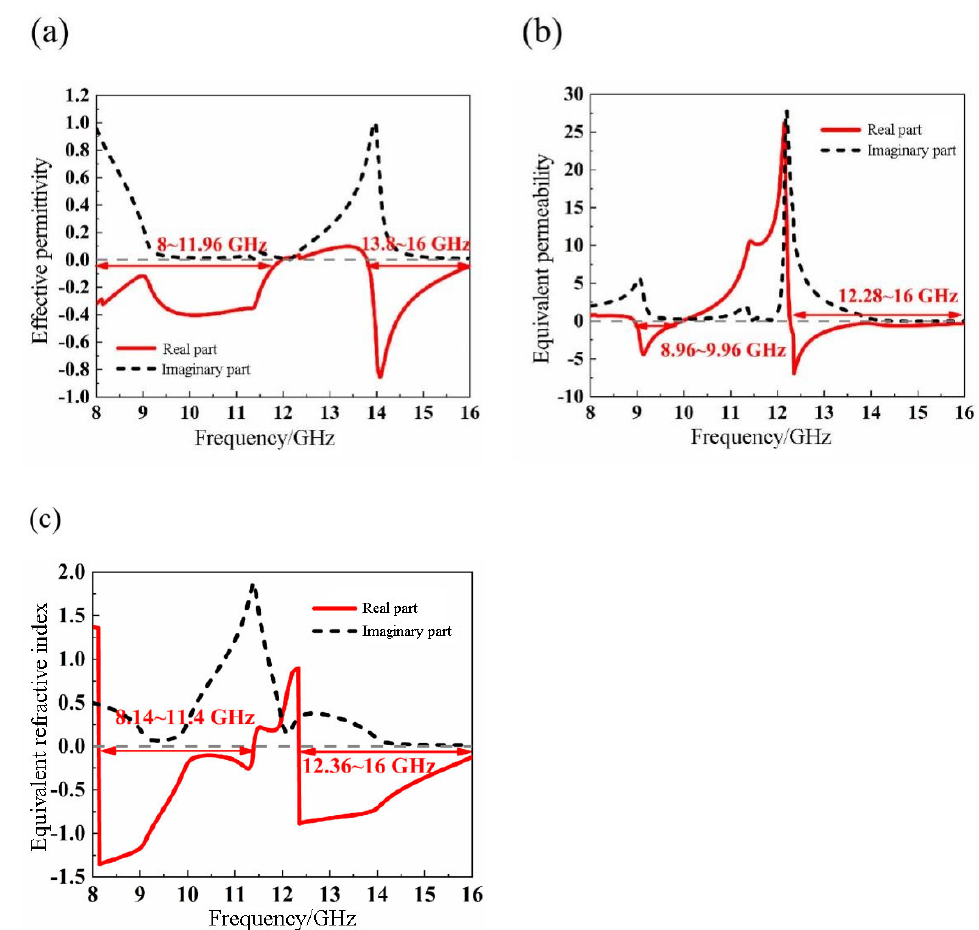
Figure 12. Graph of equivalent electromagnetic parameters extraction ( a ) Equivalent permittivity ε . ( b ) Equivalent permeability µ . ( c ) Equivalent refractive index n .